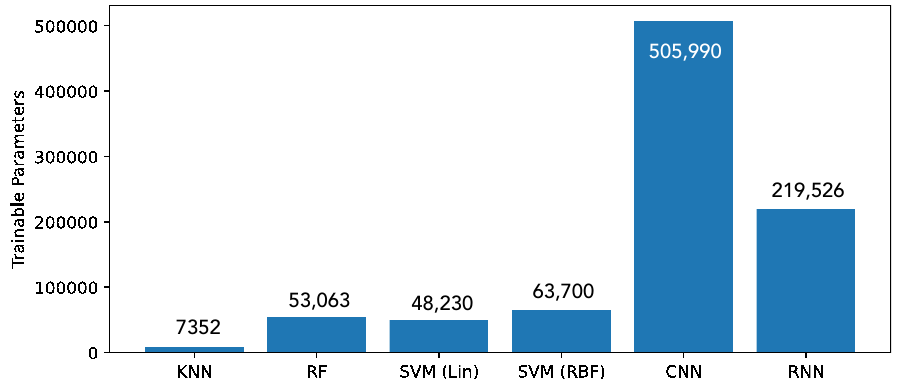
Figure 14. Number of trainable paramaters for each of the best